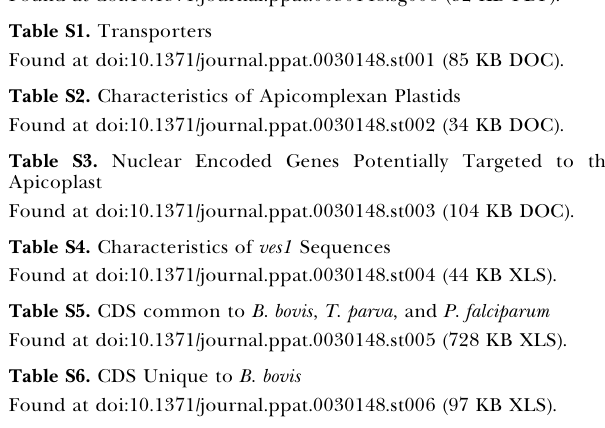
Table S7. CDS Unique to T. parva Table S8. CDS Unique to P.